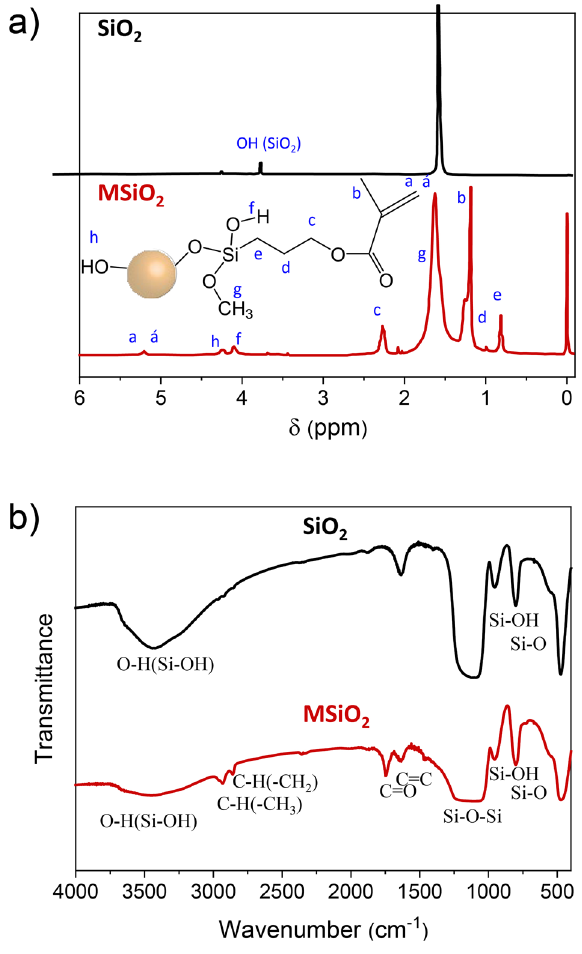
Figure 2. ( a ) 1 H-NMR spectra of bare SiO 2 200 nm and MSiO 2 200 nm and ( b ) FT-IR spectra of bare SiO 2 200 nm and MSiO 2 200